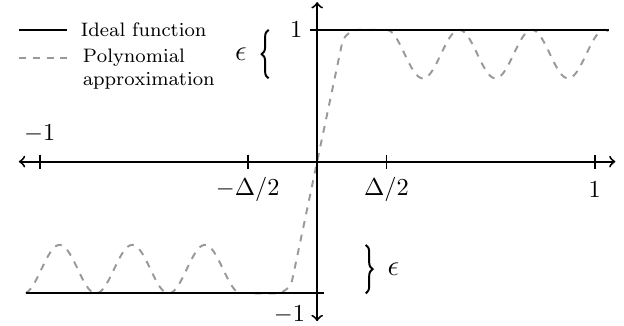
FIG. 6. An illustration of (cid:15)( x ) (solid) and its polynomial ( x ) (dashed). Note how P (cid:15) ( x ) stays within approximation, P (cid:15) (cid:14) (cid:14) , (cid:16) , (cid:16) (cid:14) of the sign function outside of the region ((cid:16)/ 2, (cid:16)/ 2 ) , while deviating from (cid:15)( x ) within this region. The shifted version of this function is constructed in much the same